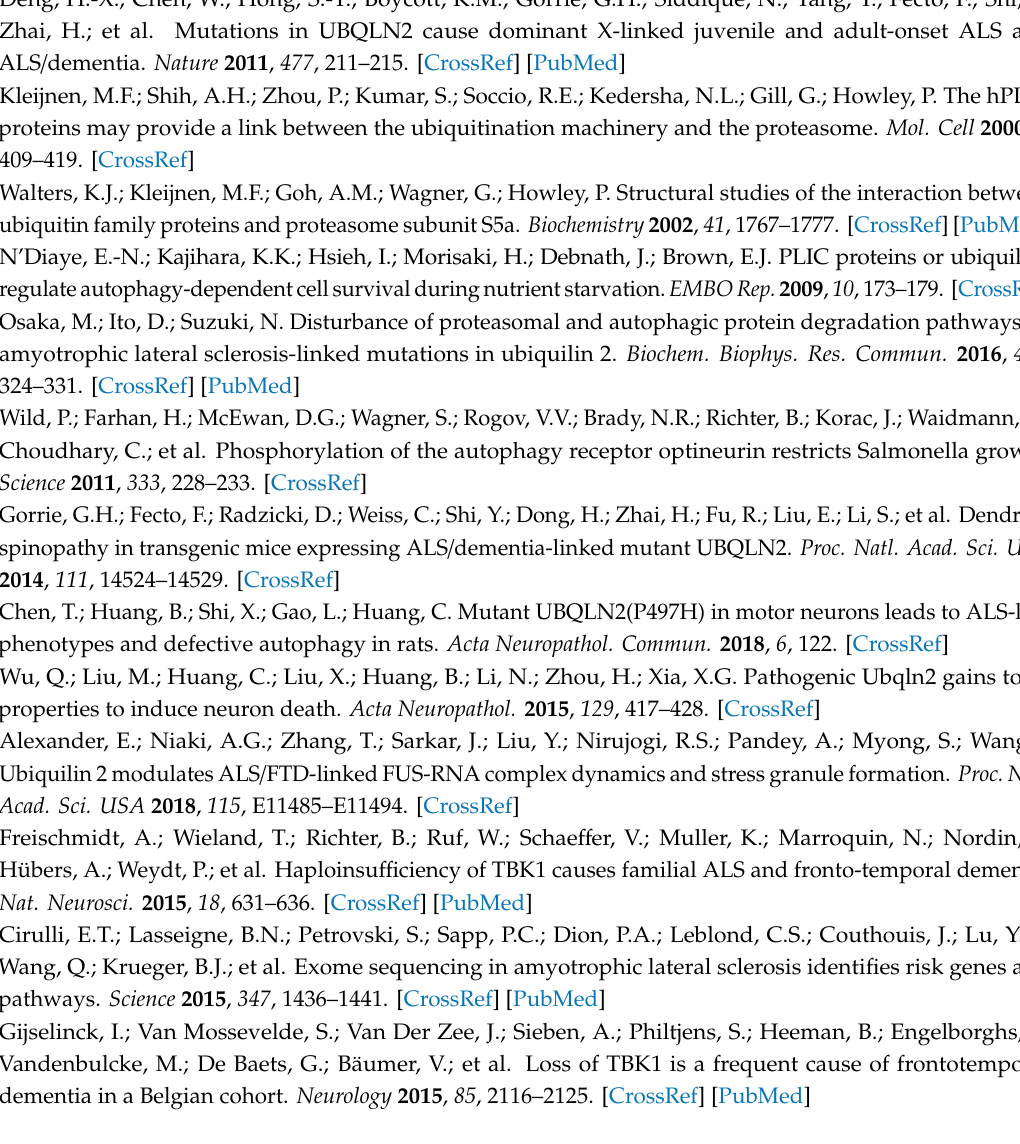
Figure S1: TBK1 precipitates UBQLN2. Figure S2: UBQLN2 has no e ff ect on mutant TBK1. Figure S3: UBQLN2 increases TBK1 protein stability. Figure S4: Increased expression of Ubiquilin 1 does not a ff ect TBK1 phosphorylation. Figure S5: Loss of IRF7 has no e ff ect on IFN1 production enhanced by